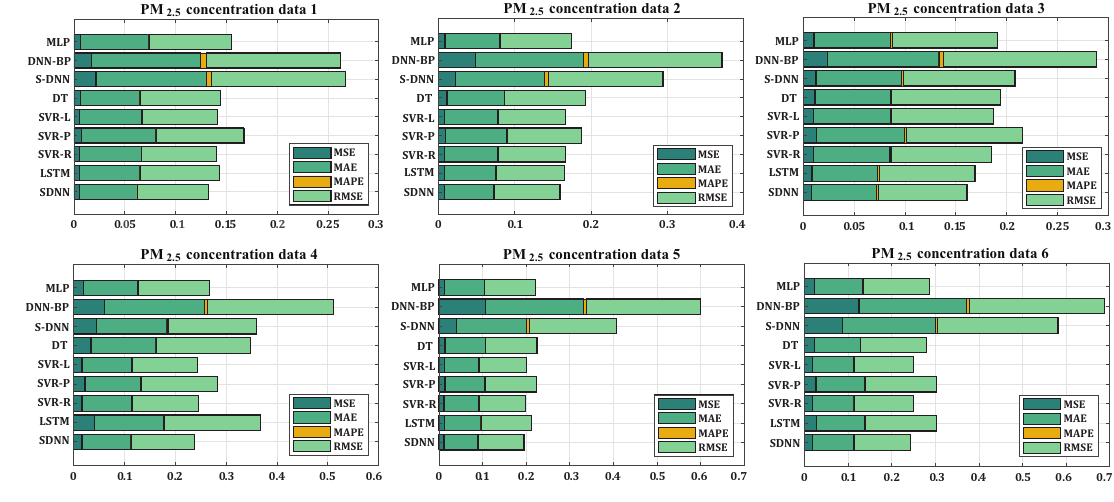
Figure 6. Comparison of the four error criteria for the six PM 2.5 concentration time